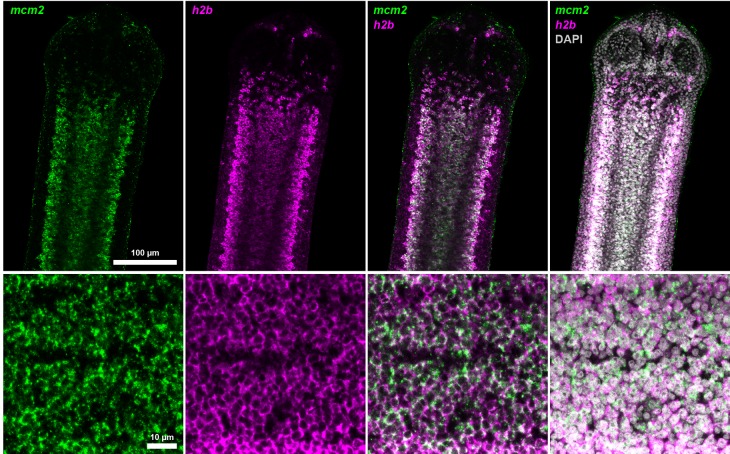
Coexpression of mcm2 and h2b.Confocal section of dFISH to detect mcm2 (green) and h2b (magenta) in the neck parenchyma at low (top) and high (bottom) magnification.